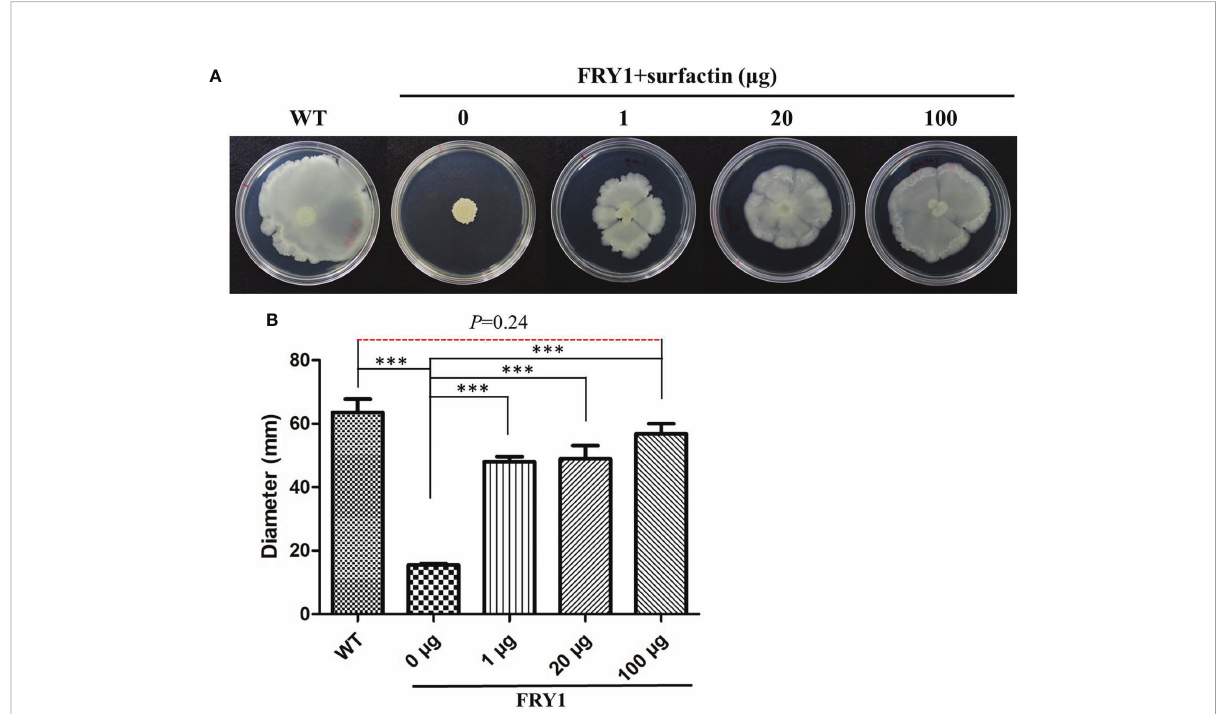
FIGURE 9 Surfactin could rescue the swarming motility of D srf mutant. (A) Solution of 10 m l containing 1 m g, 20 m g or 100 m g of surfactin were spotted on the center of 0.7% solid LB medium before dropping 5 m l of strains (OD 600 = 1) onto the top, and then incubated at 37°C for 48 h (B) Graph of (A) . P values were calculated by t -test, “ *** ” represents P < 0.001 as compared to the D srf mutant (FRY1) in the absence of